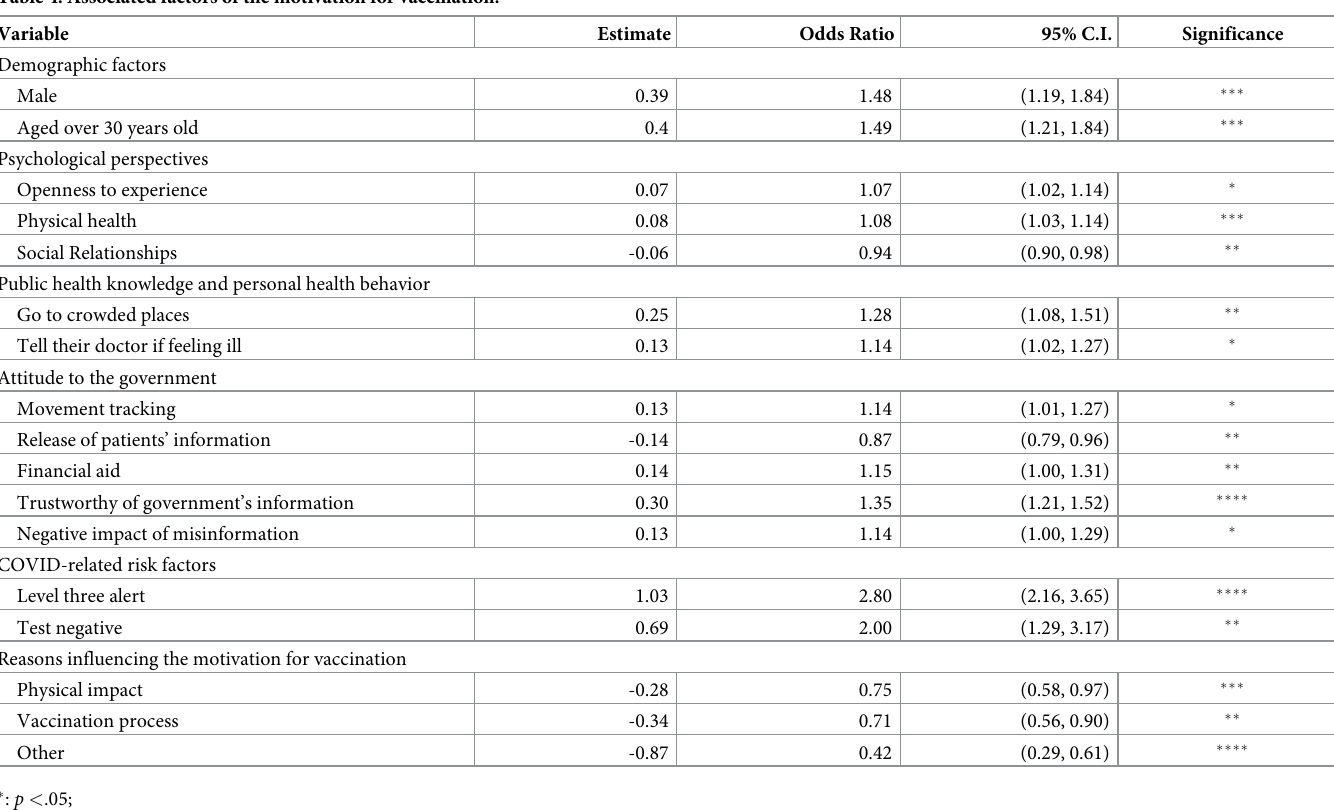
Table 4. Associated factors of the motivation for